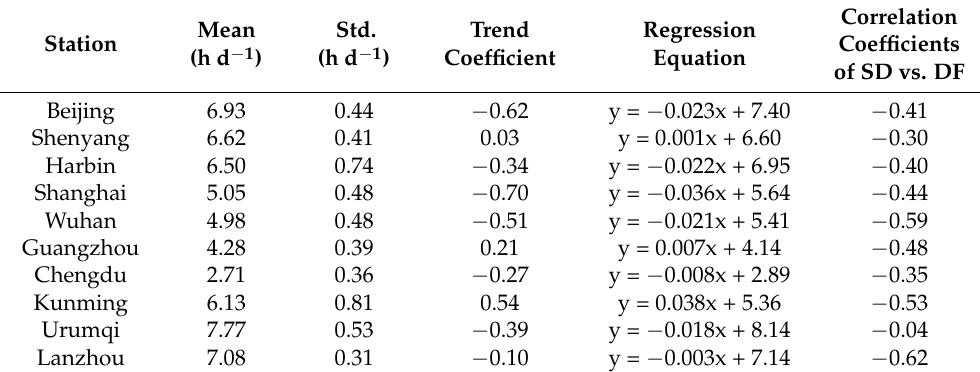
Table 2. Statistical summary of SD.